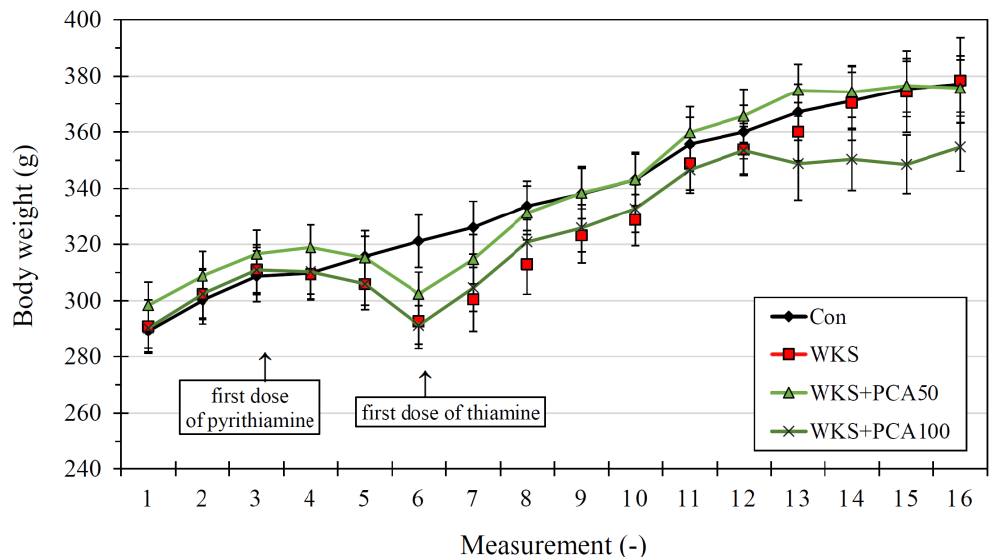
Figure 3. Changes in body weight (means ± SEM) in rats from the control group (Con), the PTD-induced WKS group (WKS), and the PTD-induced WKS groups treated with PCA at doses of 50 mg/kg (WKS + PCA50) or 100 mg/kg (WKS + PCA100) during the experiment. Between the administration of the first dose of pyrithiamine and the first dose of thiamine, there was a period of thiamine deficiency lasting 12 days (not applicable to control group).